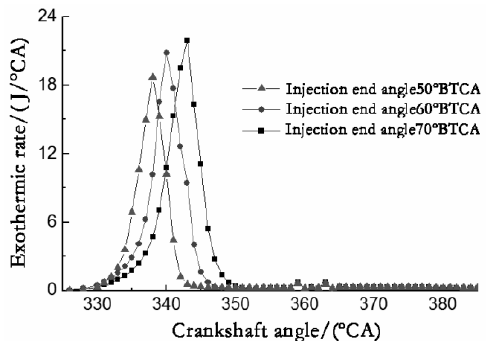
Figure 10. Heat release rate at different injection end angles.